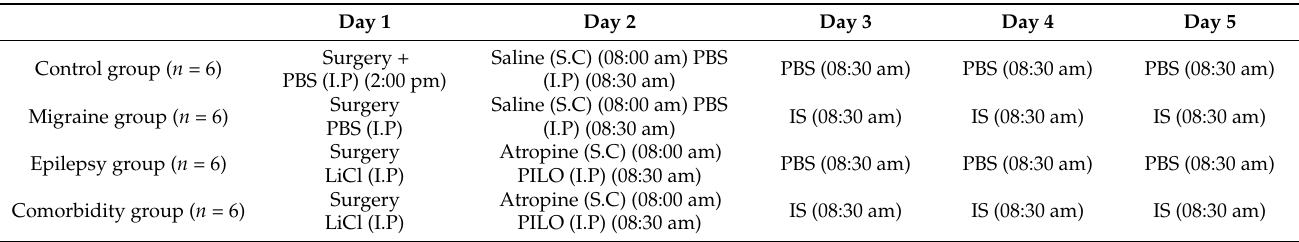
Table 1. Establishment of animal